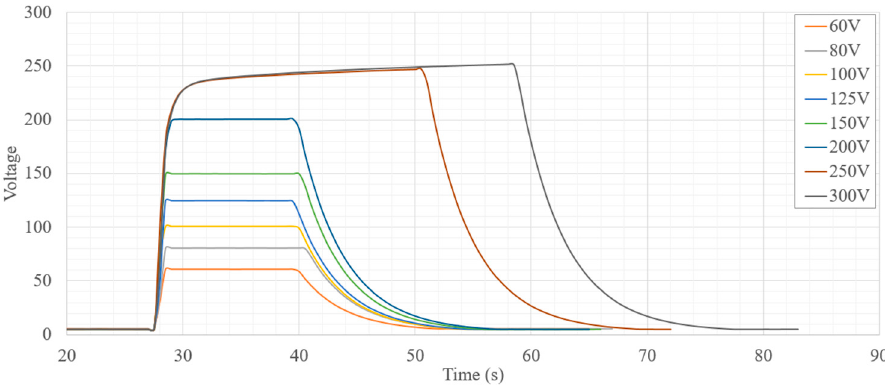
Figure 14. High voltage SMPS power on/off waveforms.